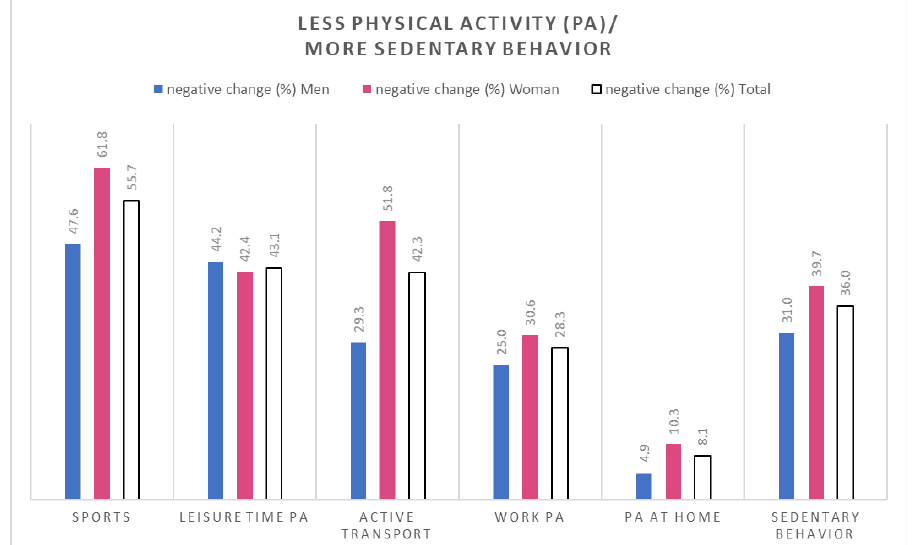
Figure 2. Proportion of participants who reported less physical activity (in five different settings) and more sedentary behavior during the new coronavirus (COVID-19) pandemic (since February 2020) than before.